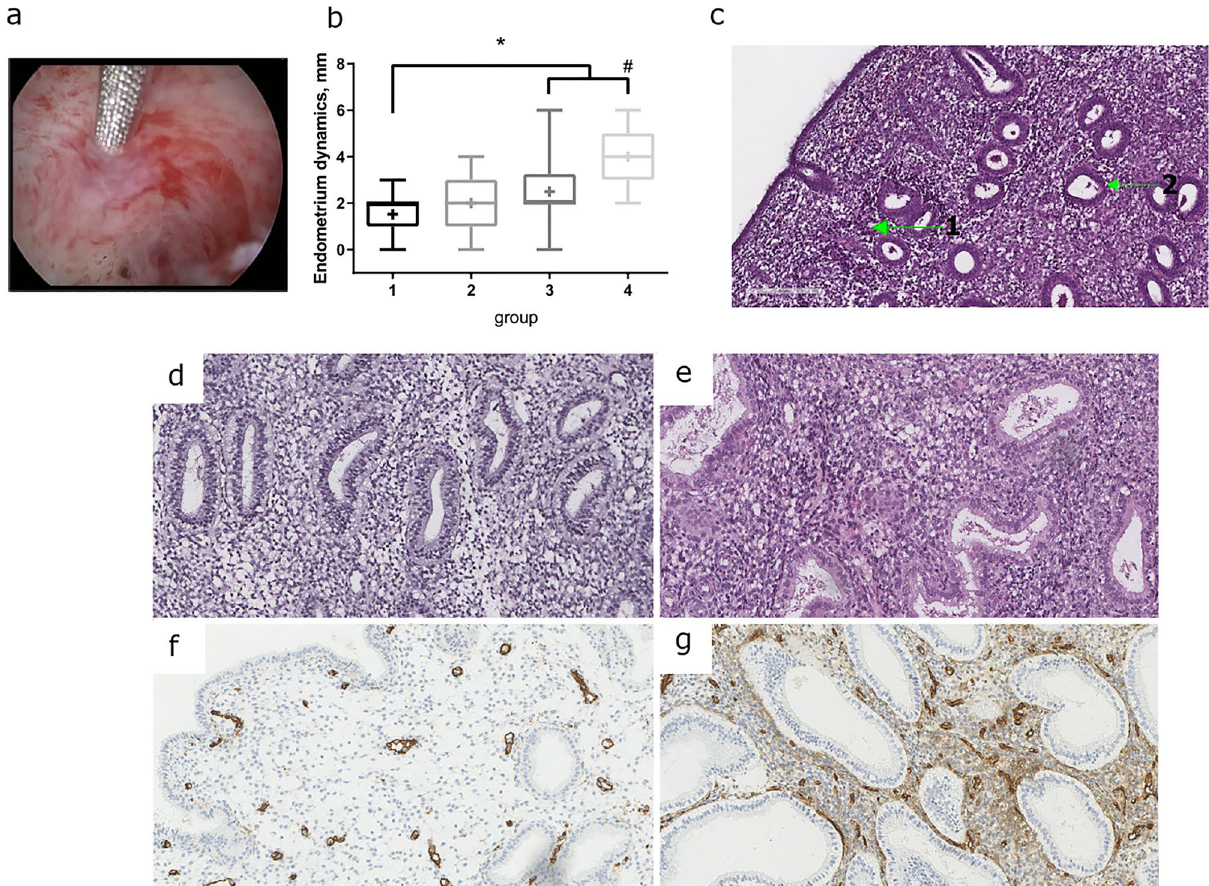
Figure 1. Endometrium parameters. Injection of autologous PRP – the image shows endoscopic needle inserted in the endometrium to the controlled depth of 2–3 mm ( a ). Endometrium thickness dynamics for the groups ( b ): * – p < 0,05; # – p < 0,05 for Group 4 vs Group 2. Histological image of endometrium with signs of fibrosis and atrophy ( c ): 1 , fibrotic foci in the stroma adjacent to endometrial glands; 2 , atrophic gland; hematoxylin and eosin, magnification × 100. Endometrium of an early stage of secretion in a patient who became pregnant (( d ) – staining with hematoxylin and eosin, ( f ) – immunohistochemical expression of CD34); endometrium of an inferior secretion phase in a patient who did not become pregnant (( e ) – staining with hematoxylin and eosin, ( g ) – immunohistochemical expression of CD34). Magnification × 200. Software: ImageScope